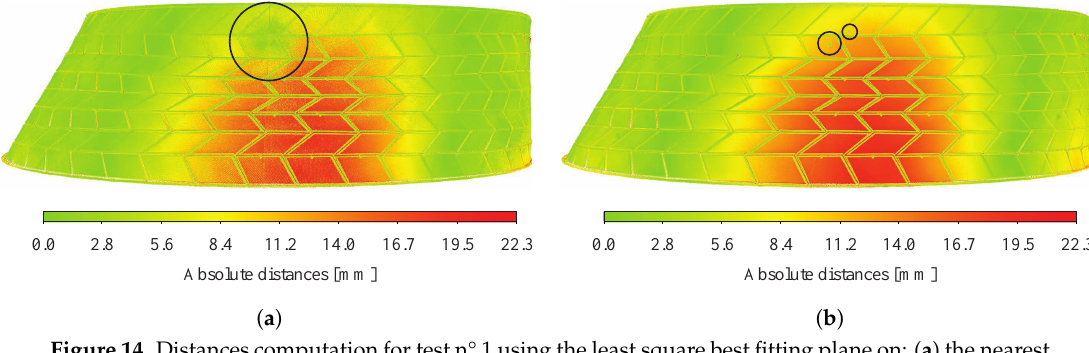
Figure 14. Distances computation for test n° 1 using the least square best fitting plane on: ( a ) the nearest point and its 6 neighbouring points; ( b ) the nearest point and its 99 neighbouring points.